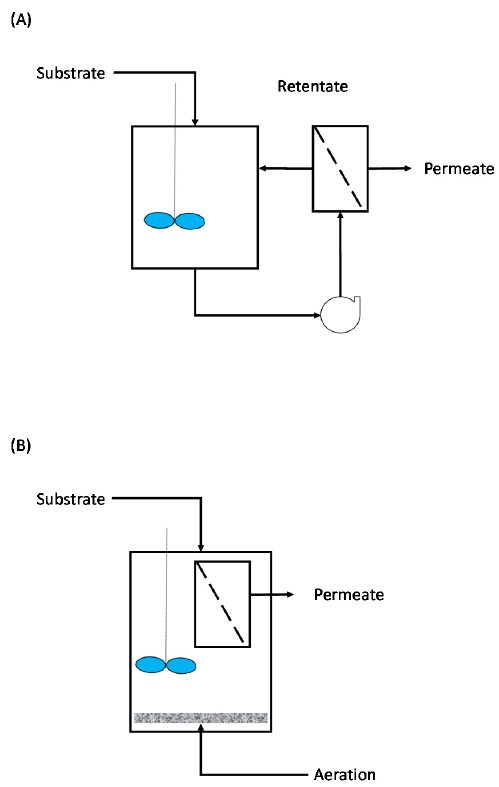
Figure 17. Basic MBR configurations: ( A ) side-stream or sMBR and ( B ) immersed MBR or iMBR.